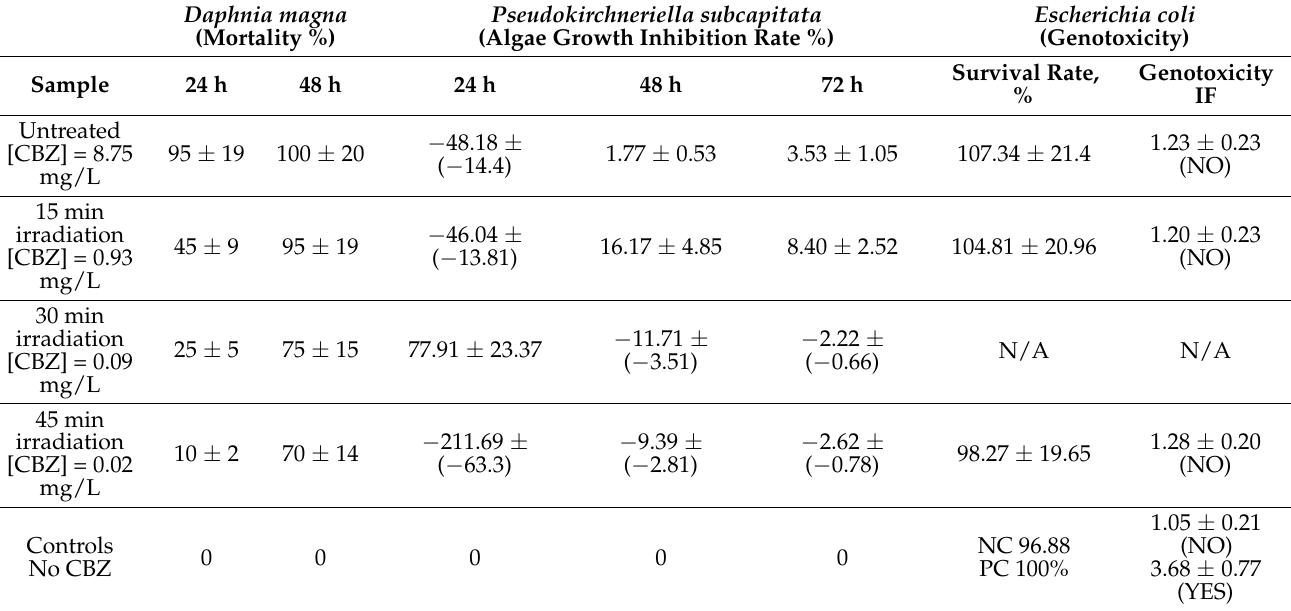
Table 4. Acute toxicity and genotoxic effects of CBZ solutions *.